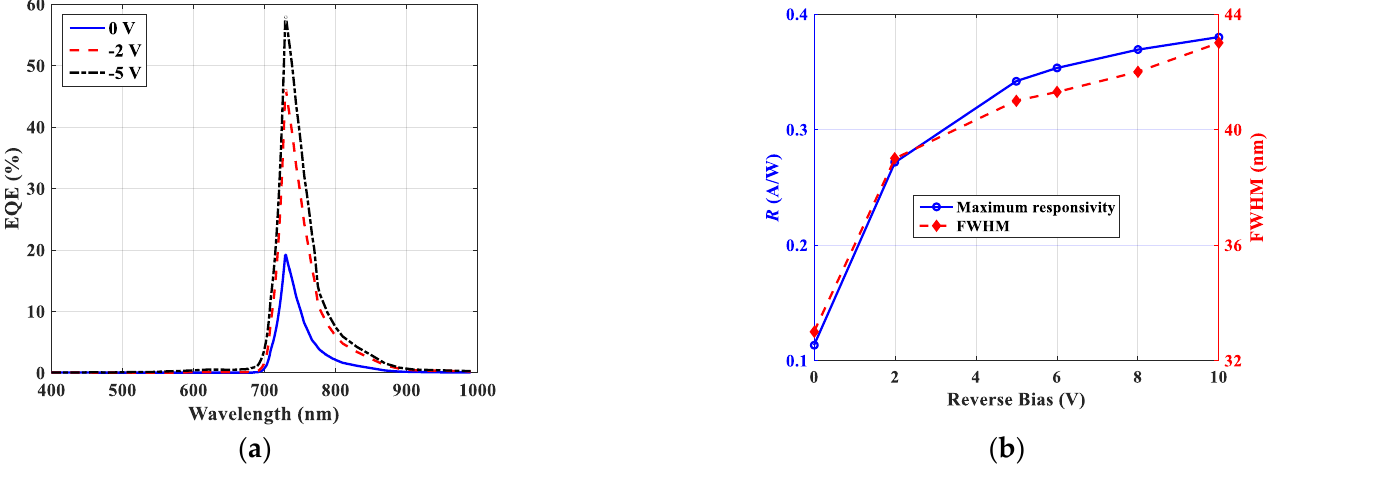
Figure 6. Impact of reverse bias on ( a ) the EQE characteristics and ( b ) peak responsivity and full width at half maximum.